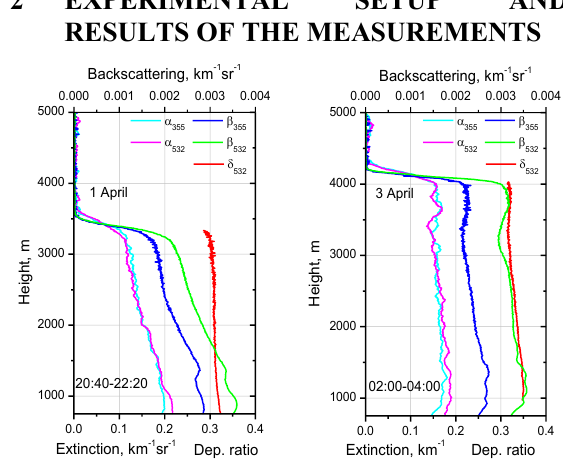
Figure 1. Vertical profiles of aerosol backscattering and extinction coefficients at 355 nm and 532 nm together with particle depolarization ratio  532 for 1 April (20:40-22:20 UTC) and 3 April (02:00-04:00